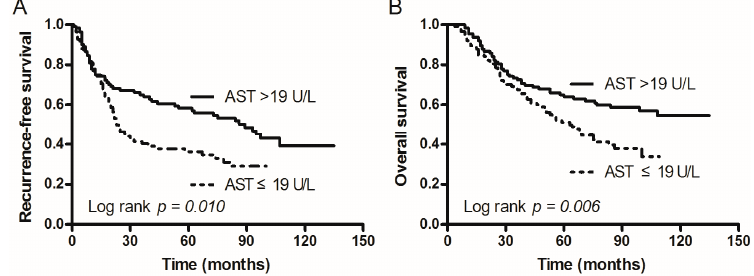
Figure 1. Kaplan–Meier survival curves of non-small cell lung cancer (NSCLC) patients were divided into two groups (AST > 19 U/L and AST ≤ 19 U/L). ( A ) Recurrence-free survival (RFS) of patients with AST. The survival of patients with AST ≤ 19 U/L was shorter than that of patients with AST > 19 U/L ( p = 0.010); ( B ) Overall survival (OS) of patients with AST. The survival of patients with AST ≤ 19 U/L was also shorter than that of patients with AST > 19 U/L ( p = 0.006). AST: aspartate aminotransferase. Table 2. Clinical and laboratory characteristics of 231 patients associated with overall survival (OS) and recurrence-free survival (RFS).